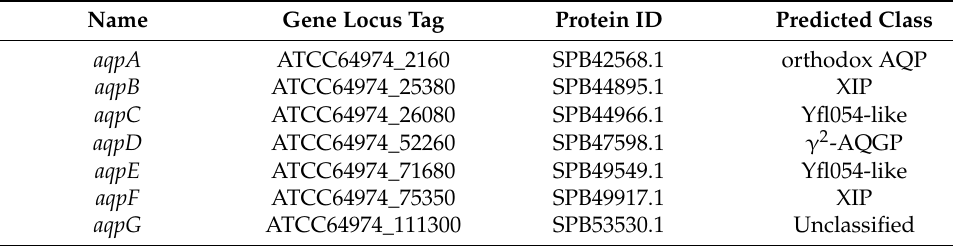
Table 2. List of A. niger N402 aquaporin